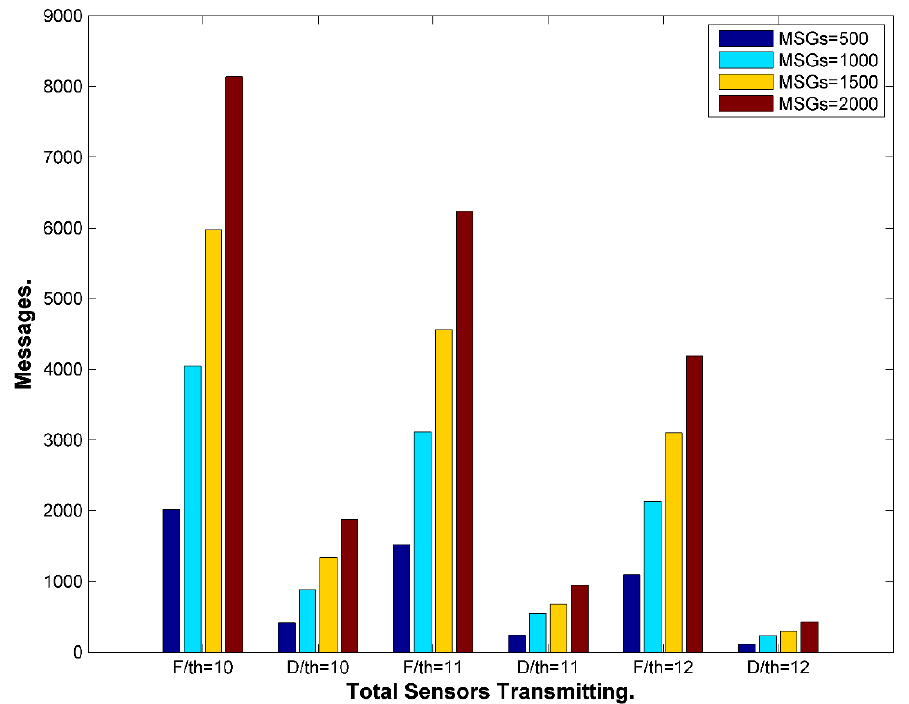
Figure 28. Simulation for busy network with different R min threshold values th = 10, 11 and 12. F stands for the number of fake messages has been reduced and D stand for the number of delayed messages to maintain R min . The simulation shows that the number of delayed messages is minimal while it decreases as the threshold